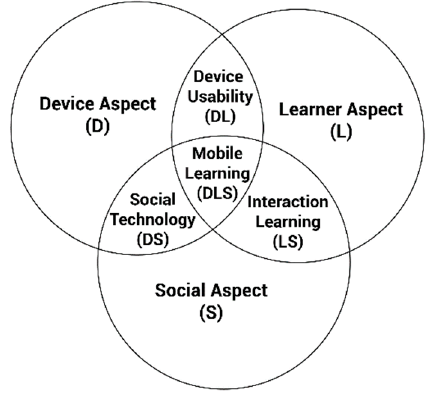
Figure 1. The Framework for the Rational Analysis of Mobile Education (FRAME) Model.